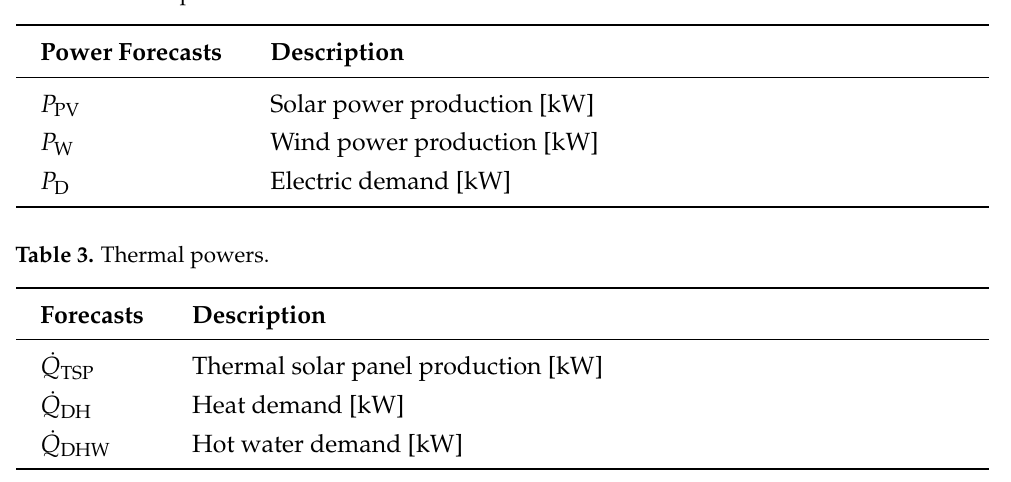
Table 2. Electric powers.